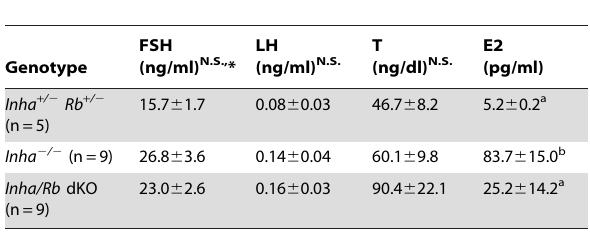
Table 1. Serum Hormone Levels for 10 wk-old Males.